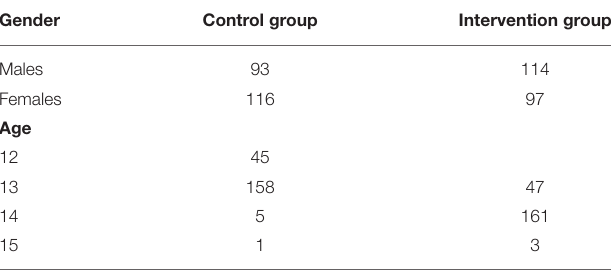
TABLE 1 | Number of participant students in the control and intervention groups with gender and age breakdown. Gender Control group Intervention